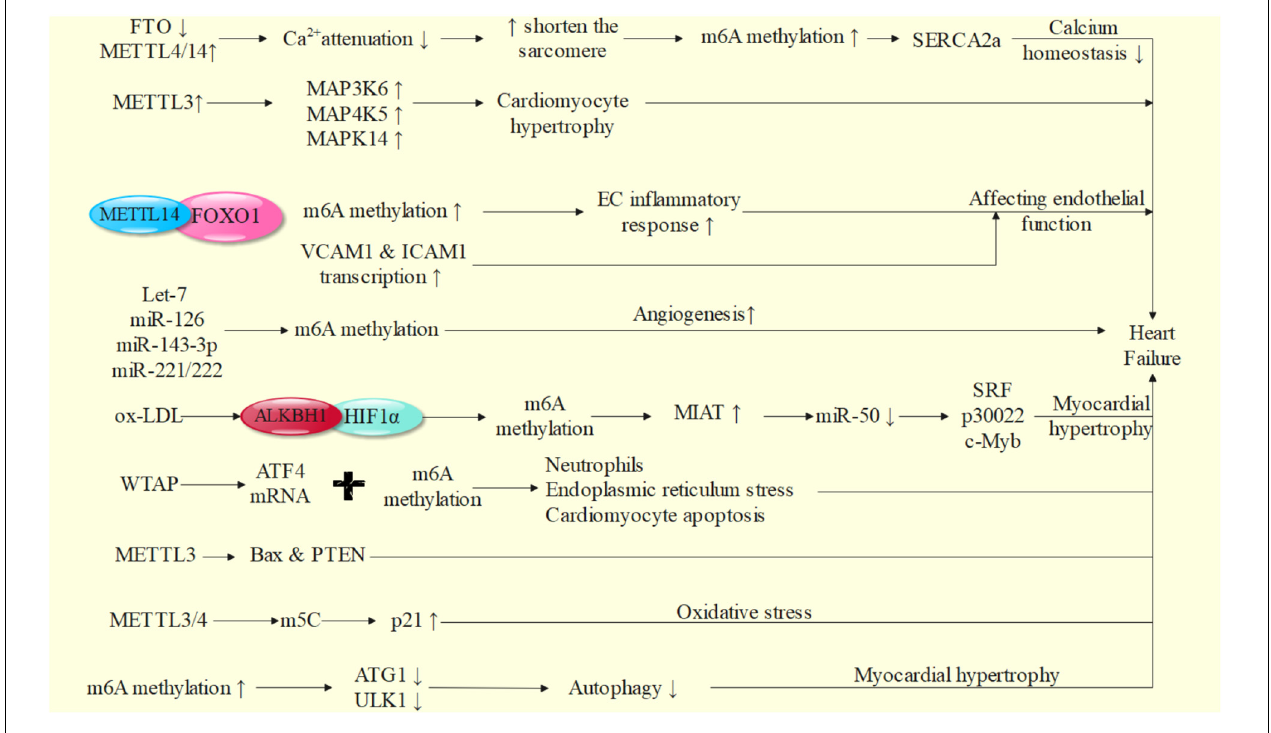
FIGURE 2 | Possible mechanism of m6A methylation in heart